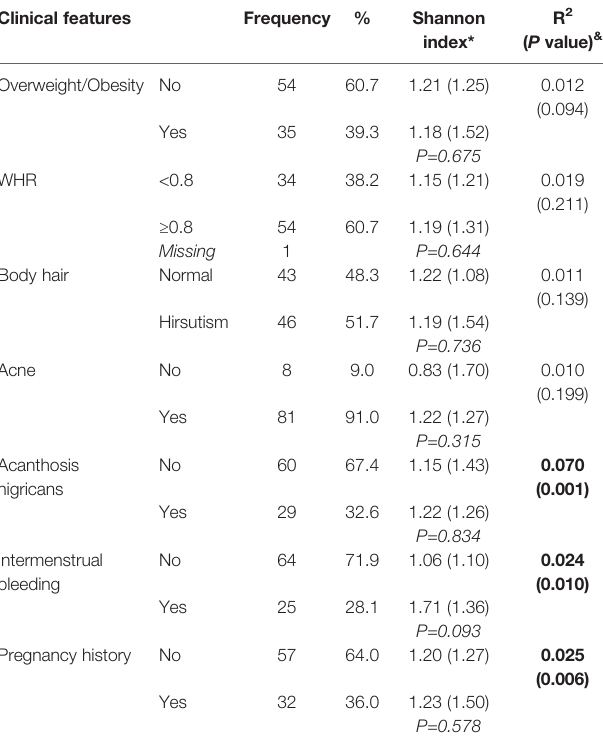
TABLE 3 | Biochemical parameters of PCOS patients and associations with vaginal